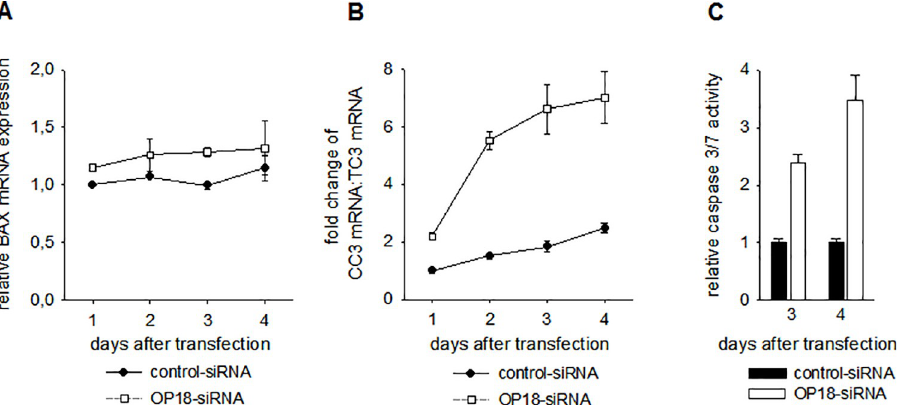
Fig 4. Apoptotic effects of OP18-suppression in ECV-304. Relative expression of the pro-apoptotic BAX mRNA (A) and increase (´fold change´) of the pro-apoptotic mRNA-ratio CC3:TC3 (B). ECV-304 cells were transfected in duplicate with 30 nM OP18- and control-siRNA and total RNA was prepared at 1, 2, 3, 4 days after transfection. Levels of BAX, CC3, TC3 and RPLP0 mRNA were detected in triplicate by qRT-PCR. Data indicate mean values ± standard deviation and are representative of three independent experiments. Levels of BAX mRNA of OP18-siRNA- or control- treated ECV-304 cells, respectively, differ marginally. Conversely, a significant difference was observed for the CC3: TC3 mRNA ratio on days 1 to 4. (C), Induction of caspase 3/7 activity after suppression of OP18. ECV-304 cells were transfected in triplicate with OP18- and control-siRNA (each 30 nM) and the relative caspase 3/7 activity was normalized to cell viability. The data indicate mean values ± standard deviation and are representative of three independent experiments. At day 3 and 4 after transfection, OP18-siRNA treated ECV-304 cells show a significant increase in caspase 3/7 activity compared to control